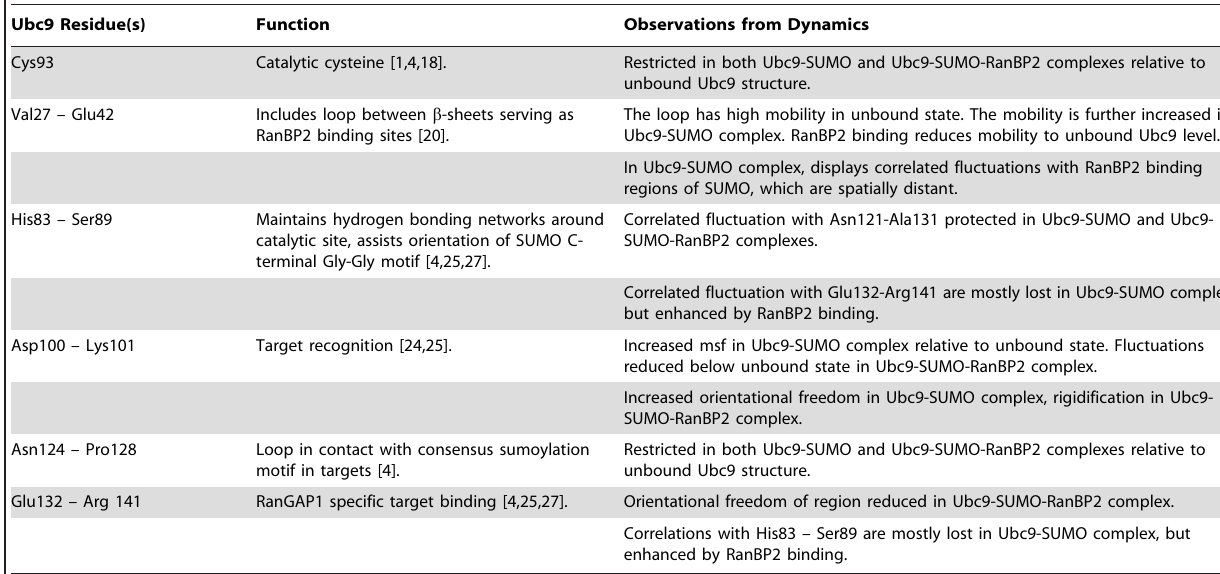
Table 3. Summary of key residues and related